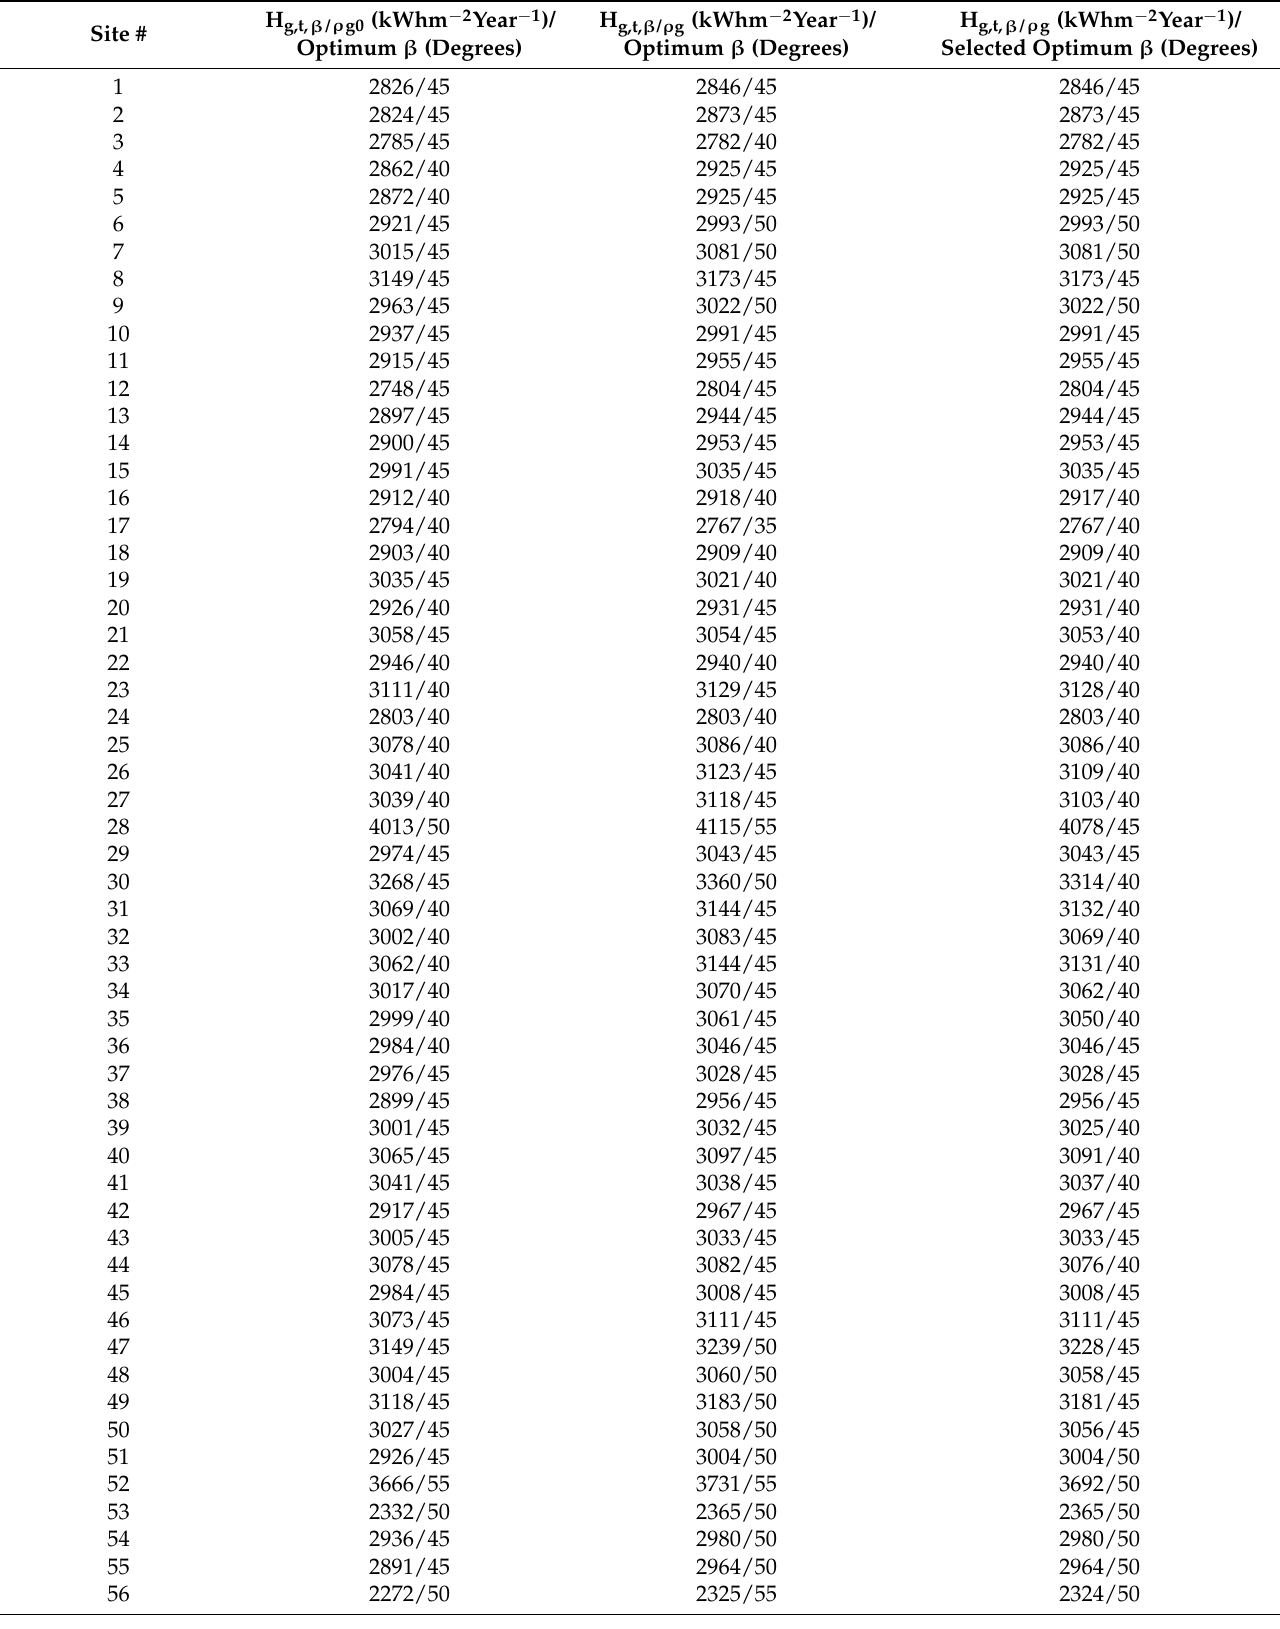
Table 2. Maximum H g,t, β annual sums for the 82 sites in Saudi Arabia for optimal tilt angles, opt. β , with reference albedo ρ ρ g , under all-sky conditions for the period 2005–2016. The H g values are rounded g0 and a near-real albedo